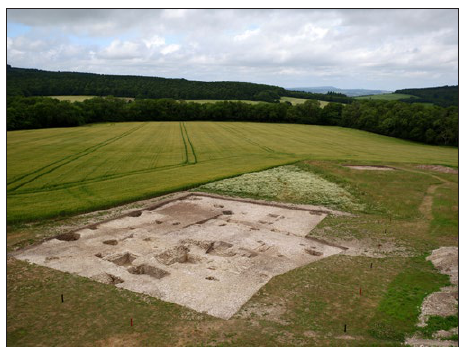
Figure 5: The excavation area looking north, at the end of 2017. Trench 17 in the fore- ground, with the under-crofts of the tower building visible at the southern end. Note the view through the Cocking Gap. (Pegs at 5 m separation). Photo: MBR.